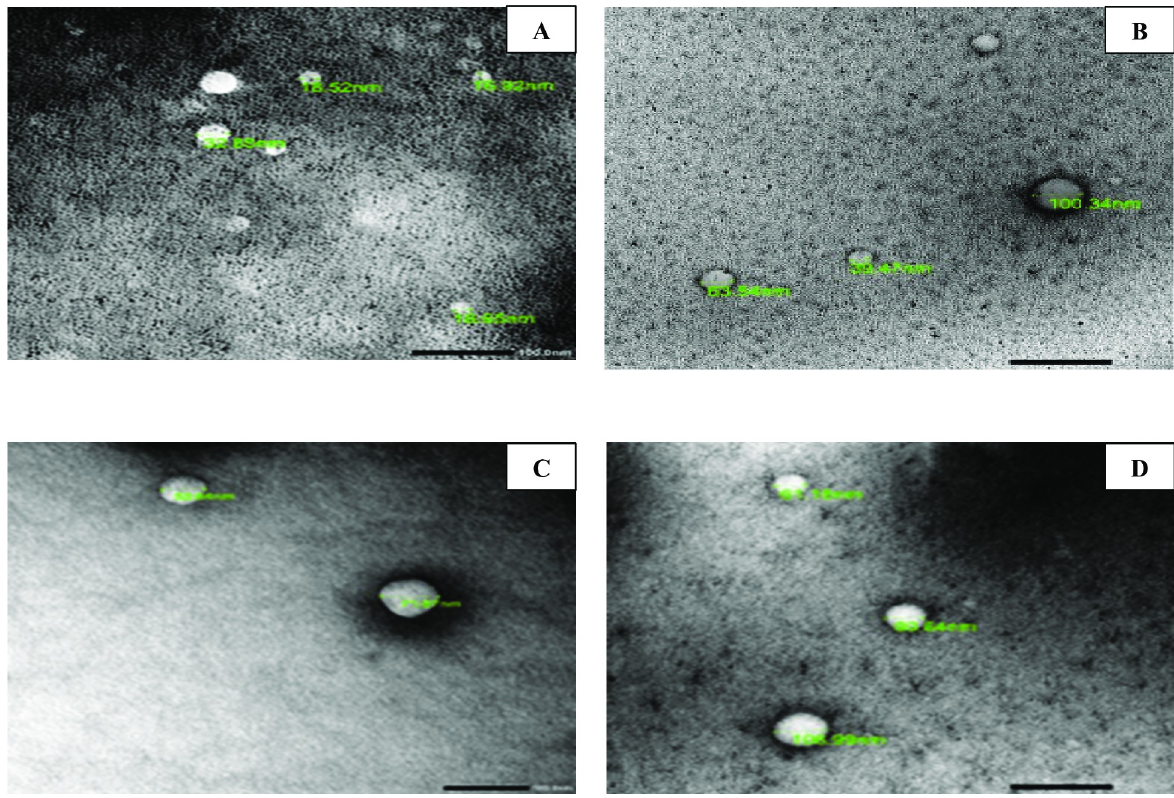
Fig 3. TEM micrographs of the prepared NPs revealing increase in particle size upon drug loading (X 55,000). (A) CS/Alg NPs. (B) Spiramycin loaded CS/Alg NPs. (C) Propolis loaded CS/Alg NPs. (D) Spiramycin/propolis loaded CS/Alg NPs.